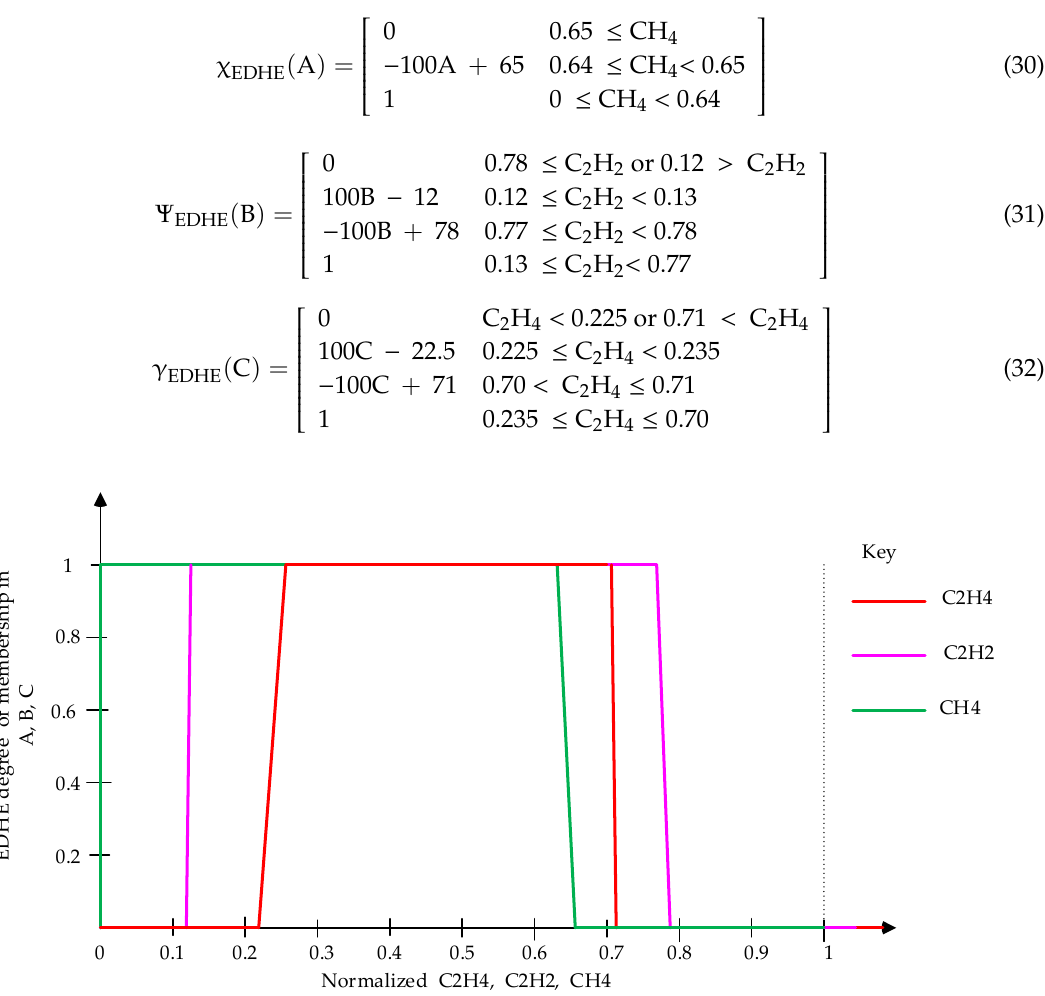
Figure 7. Fuzzy mapping curves for synthesizing electrical discharges of low energy (EDLE) faults.